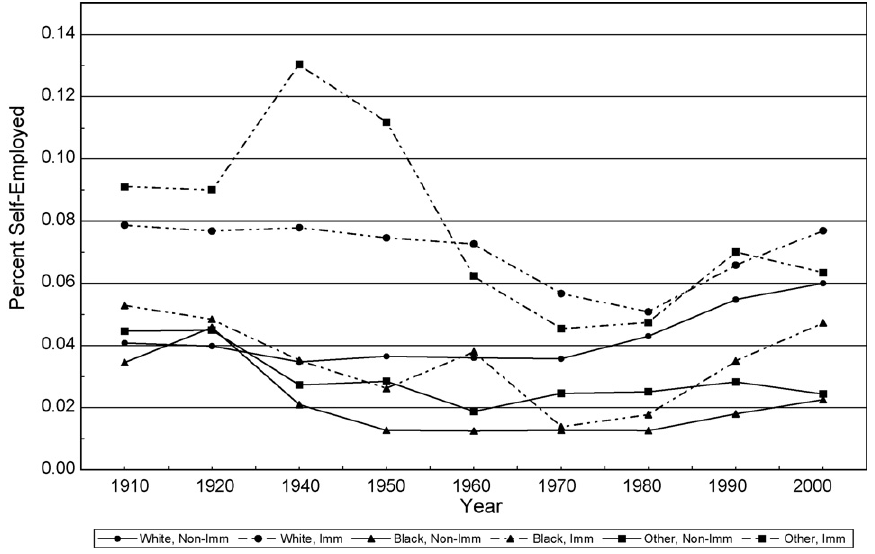
Fig. 4. U.S. self-employment rates: